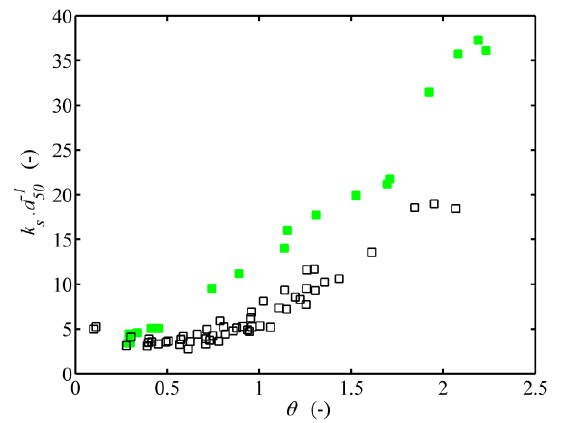
Fig. 10. Concentration at bottom of collisional layer versus dimensionless bed shear stress, Legend: blue circle – obtained from experiment using method [8], black square – obtained from experimental concentration